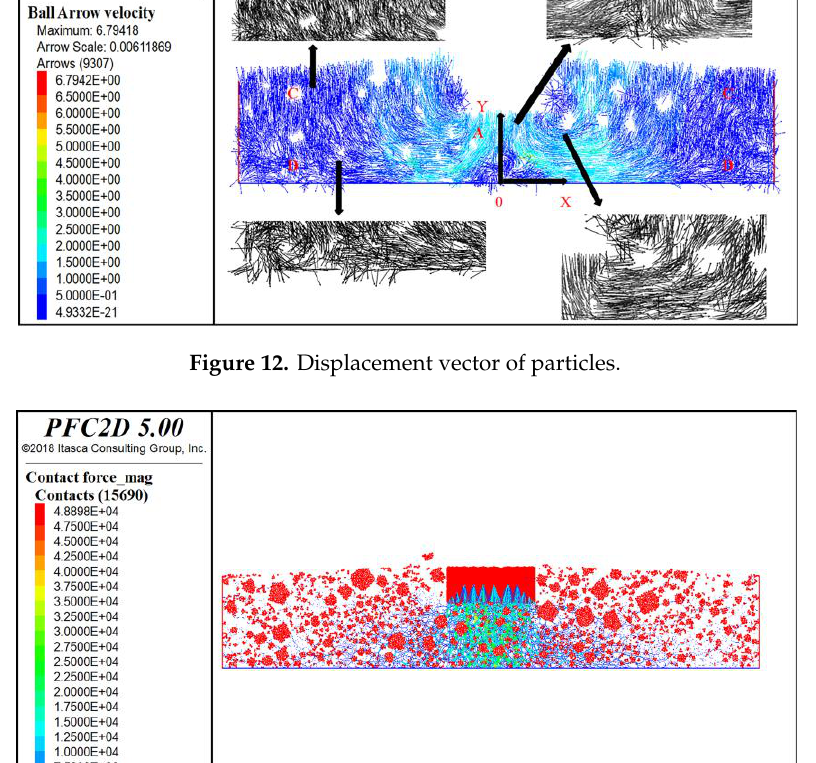
Figure 13. Contact force of particles.